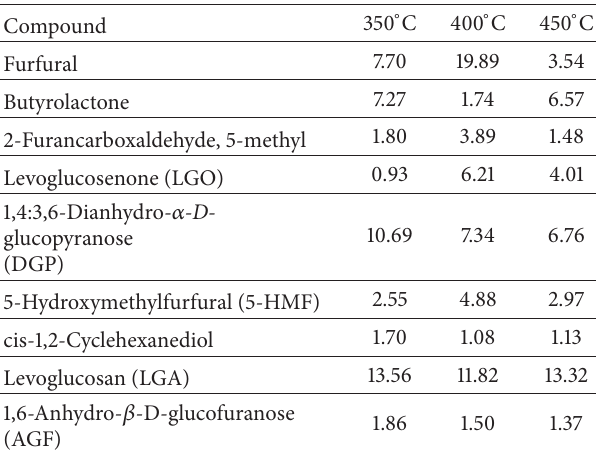
Table 2: The effect of reaction temperature on the biooil compo- nents obtained from cellulose pyrolysis catalyzed by 0.5 Zn/ZSM-5 (peak area% in the